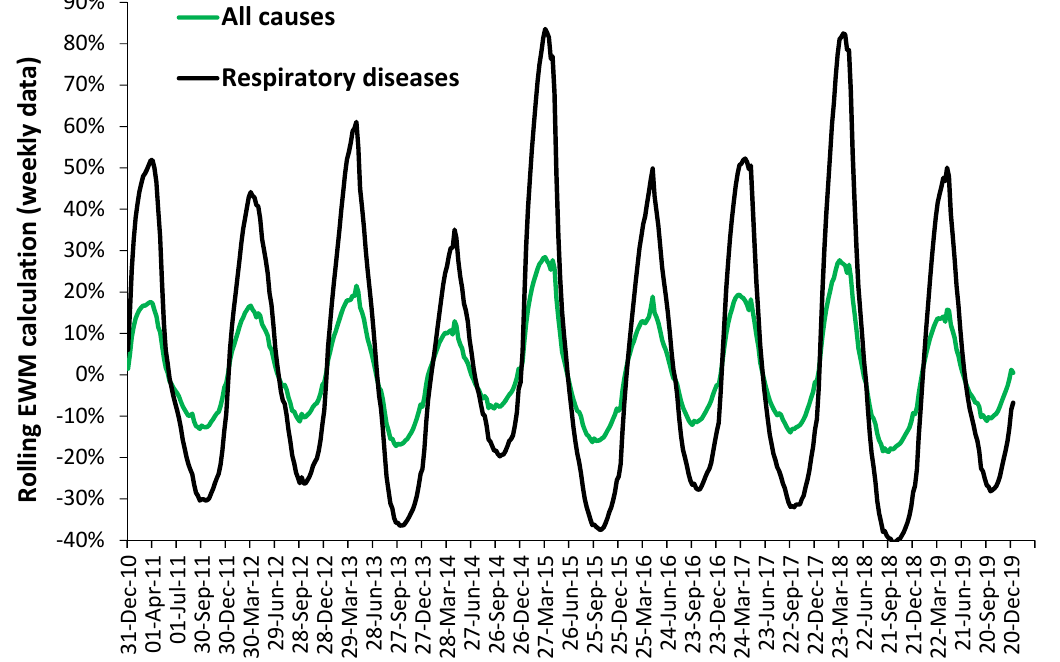
Figure 3. Rolling EWM calculation in England and Wales (weekly data) for respiratory diseases (ICD-10 Chapter J) and for all-cause deaths.